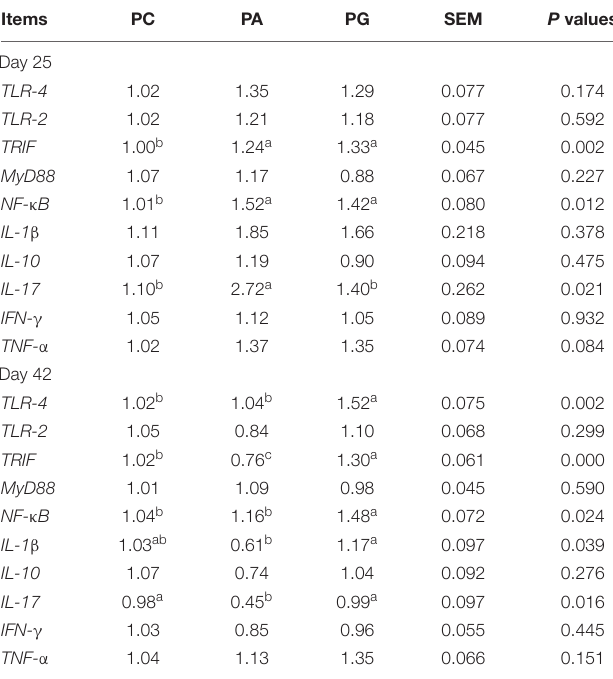
TABLE 7 | Effects of B. licheniformis and enramycin on TLR signal pathway-related gene expression in jejunum of broilers challenged with SNE.